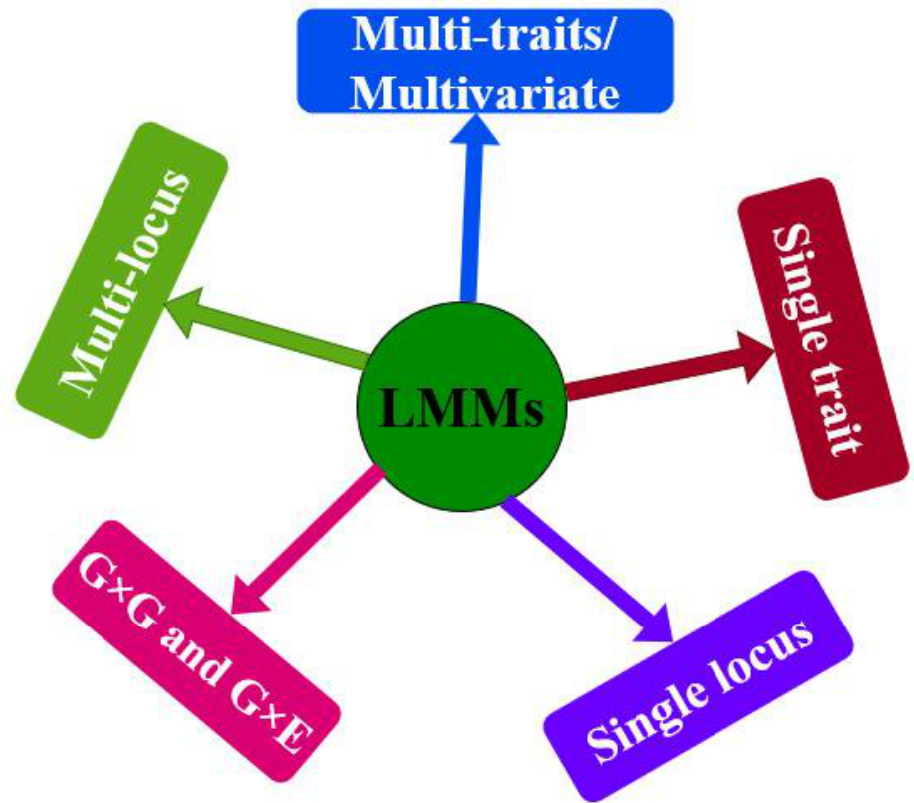
Figure 2. Types of LMMs used in GWAS for dissecting complex traits.